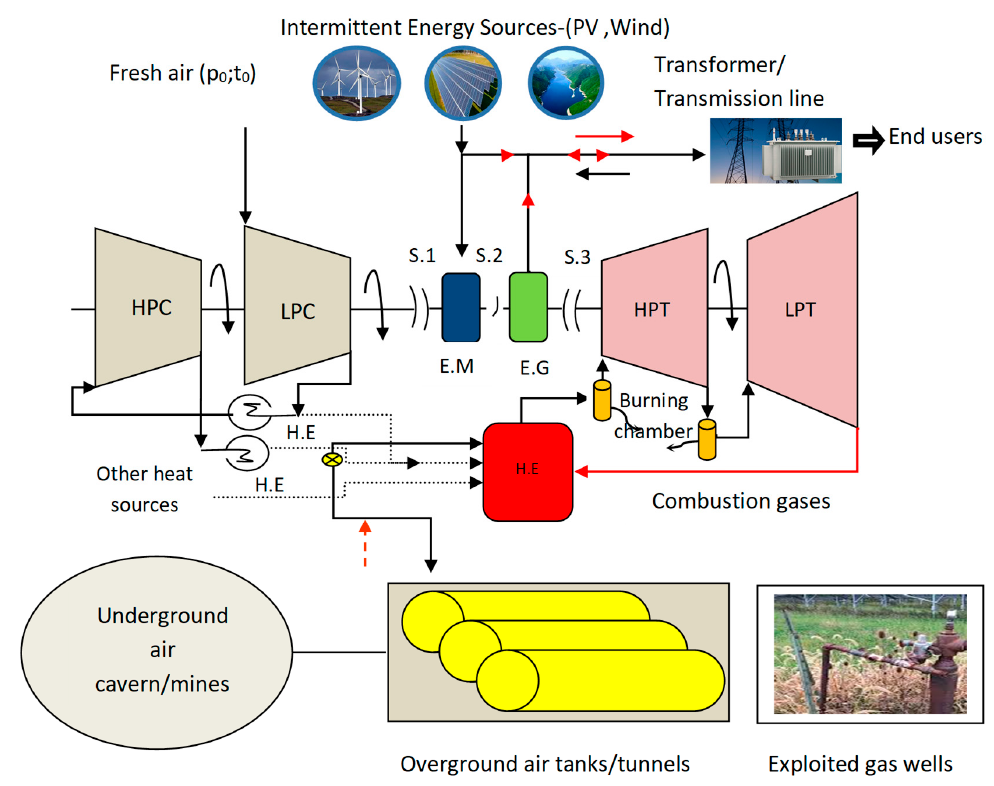
Figure 17. The proposed large-scale CAES systems show the conventional CAES equipped with Heat Exchangers (HE).